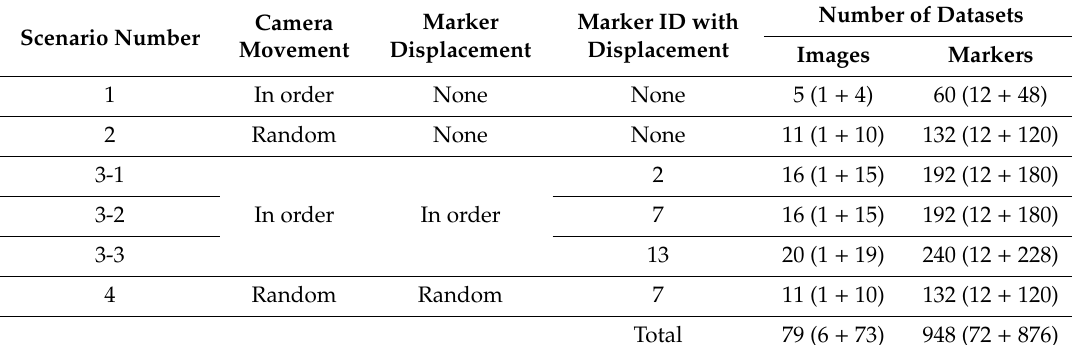
Table 2. Number of datasets.